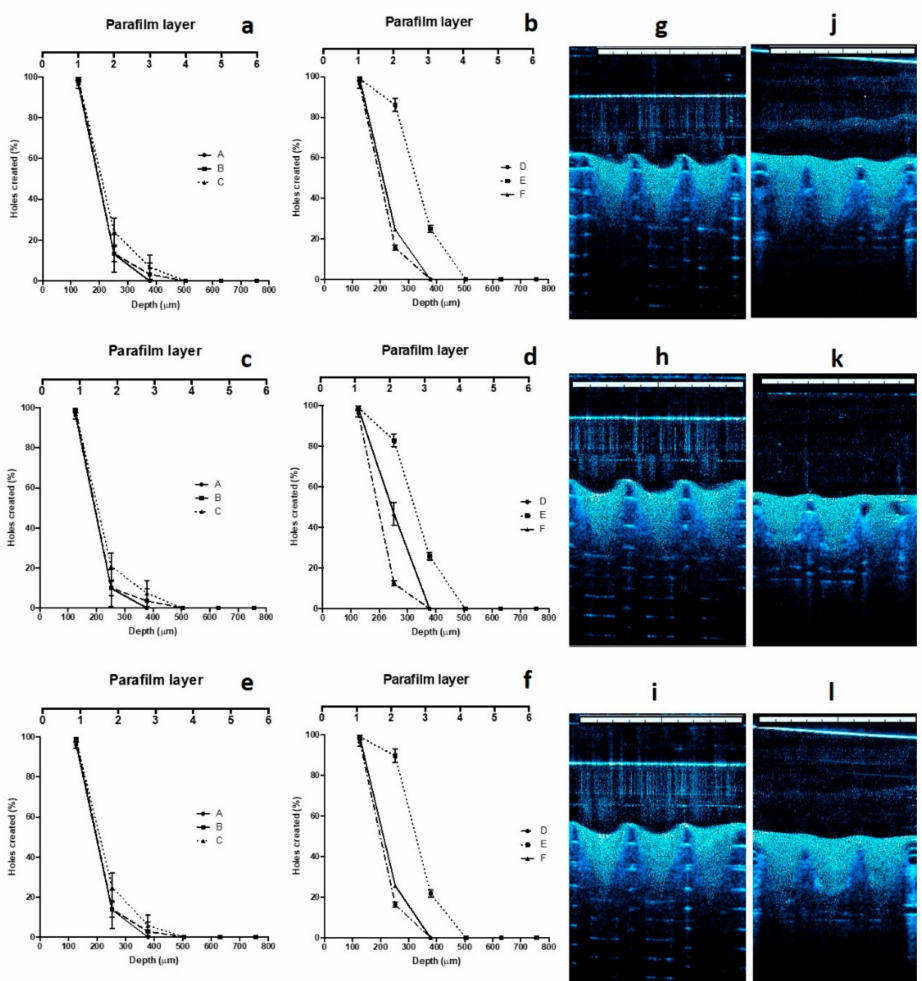
Figure 6. Number of Parafilm ® M layers inserted, approximate insertion depths and percentage of holes created in Parafilm ® M layer using an insertion force of 32 N / array using the Texture Analyzer for MN formulations containing DOX NS ( a , b ), ABZ-OX NS ( c , d ), and IVM NS ( e , f ) (means ± SD, n = 3). Representative optical coherence tomography (OCT) images of MNs containing ( g ) DOX NS, ( h ) ABZ-OX NS, and ( i ) IVM NS following insertion into Parafilm ® M film. Representative OCT images of MNs containing ( j ) DOX NS, ( k ) ABZ-OX NS, and ( l ) IVM NS following insertion into full-thickness porcine skin. The white scale bar represents a length of 1